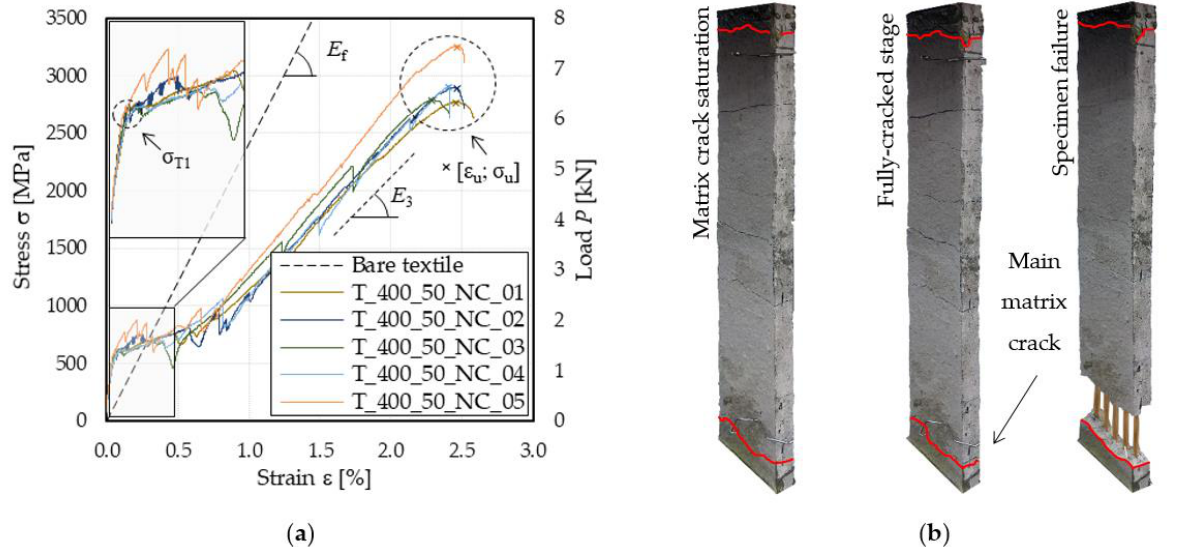
Figure 2. Clamping-grip tensile tests: ( a ) stress (load) – strain curves; ( b ) test of specimen T_400_50_NC_04: matrix cracks outside the extensometer gauge length are marked in red.